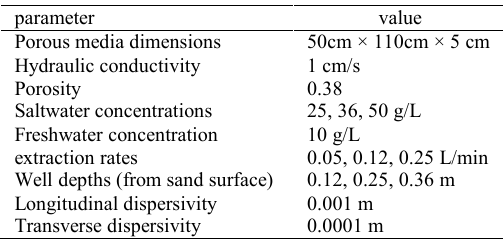
Table 1. Experimental Table 1: Experimental parameters